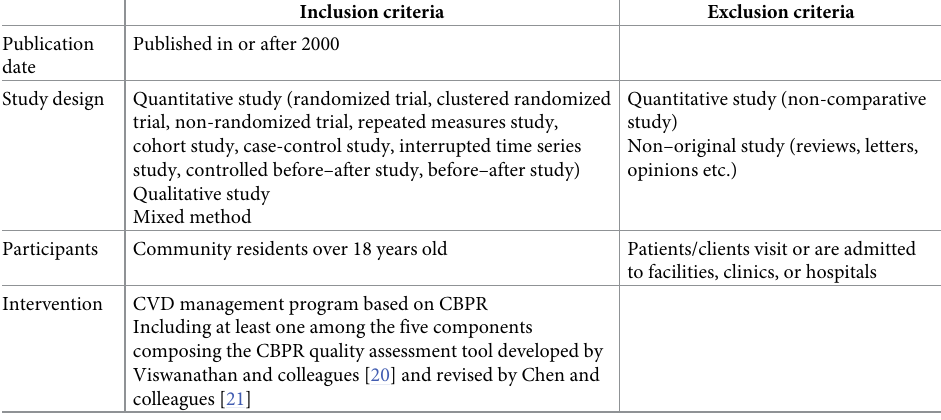
Table 1. Inclusion and exclusion